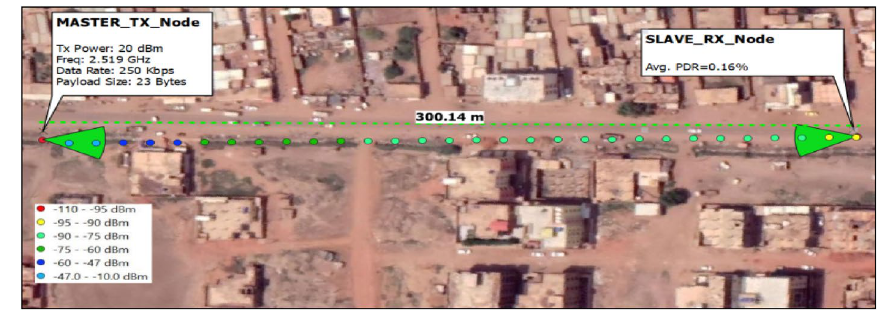
Fig. 4 First test scenario (Umm Dawm Street, Al‑Jerif East)